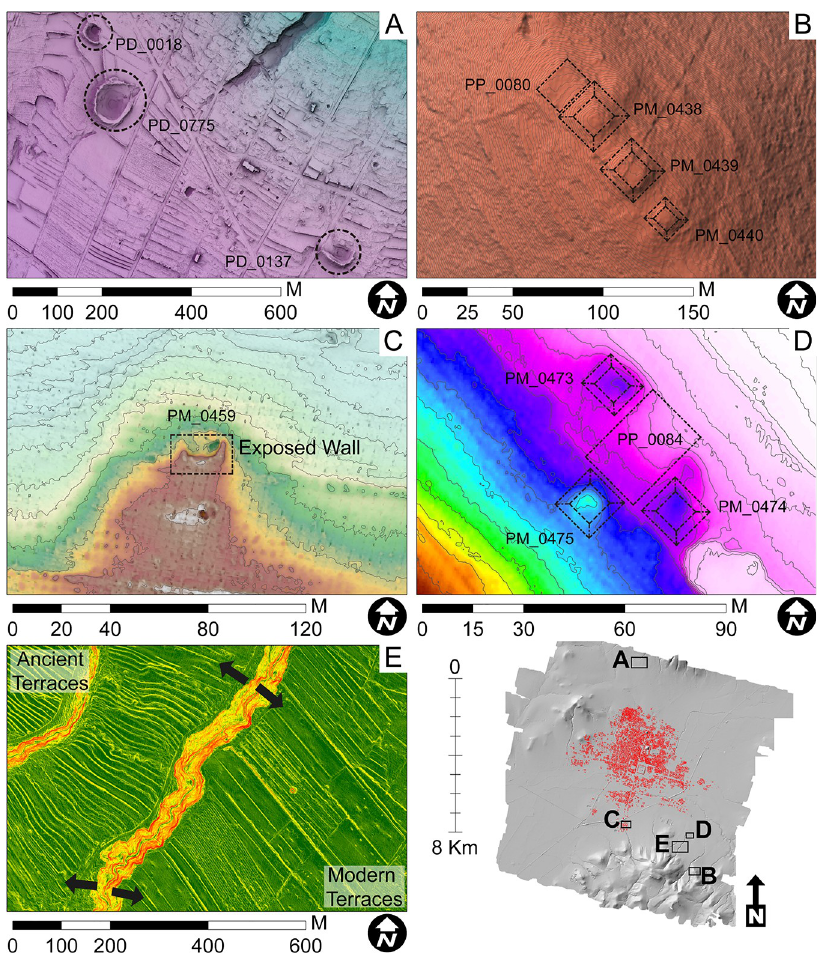
Fig 3. Five feature types identified through the lidar map illustrating a variety of visualization methods. A) depression (Skyview-factor), B) mounds (Hillshade Relief), C) structure (DEM with 0.5 m contour lines), D) mounds and a plaza (DEM with 0.5 m contour lines), and E) ancient and modern terraces (Slope Relief). Images produced with support by Ariel Texis. Published under a CC BY license, with permission from N. Sugiyama, original copyright Project Plaza of the Columns Complex